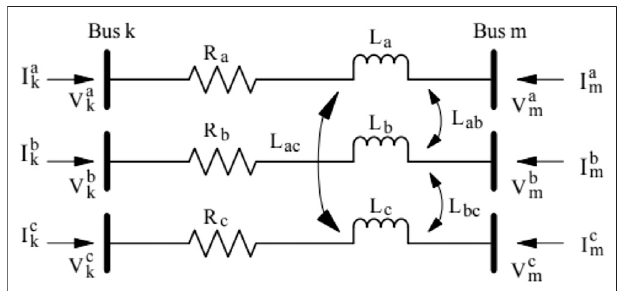
FIGURE 3 | Three phase power distribution